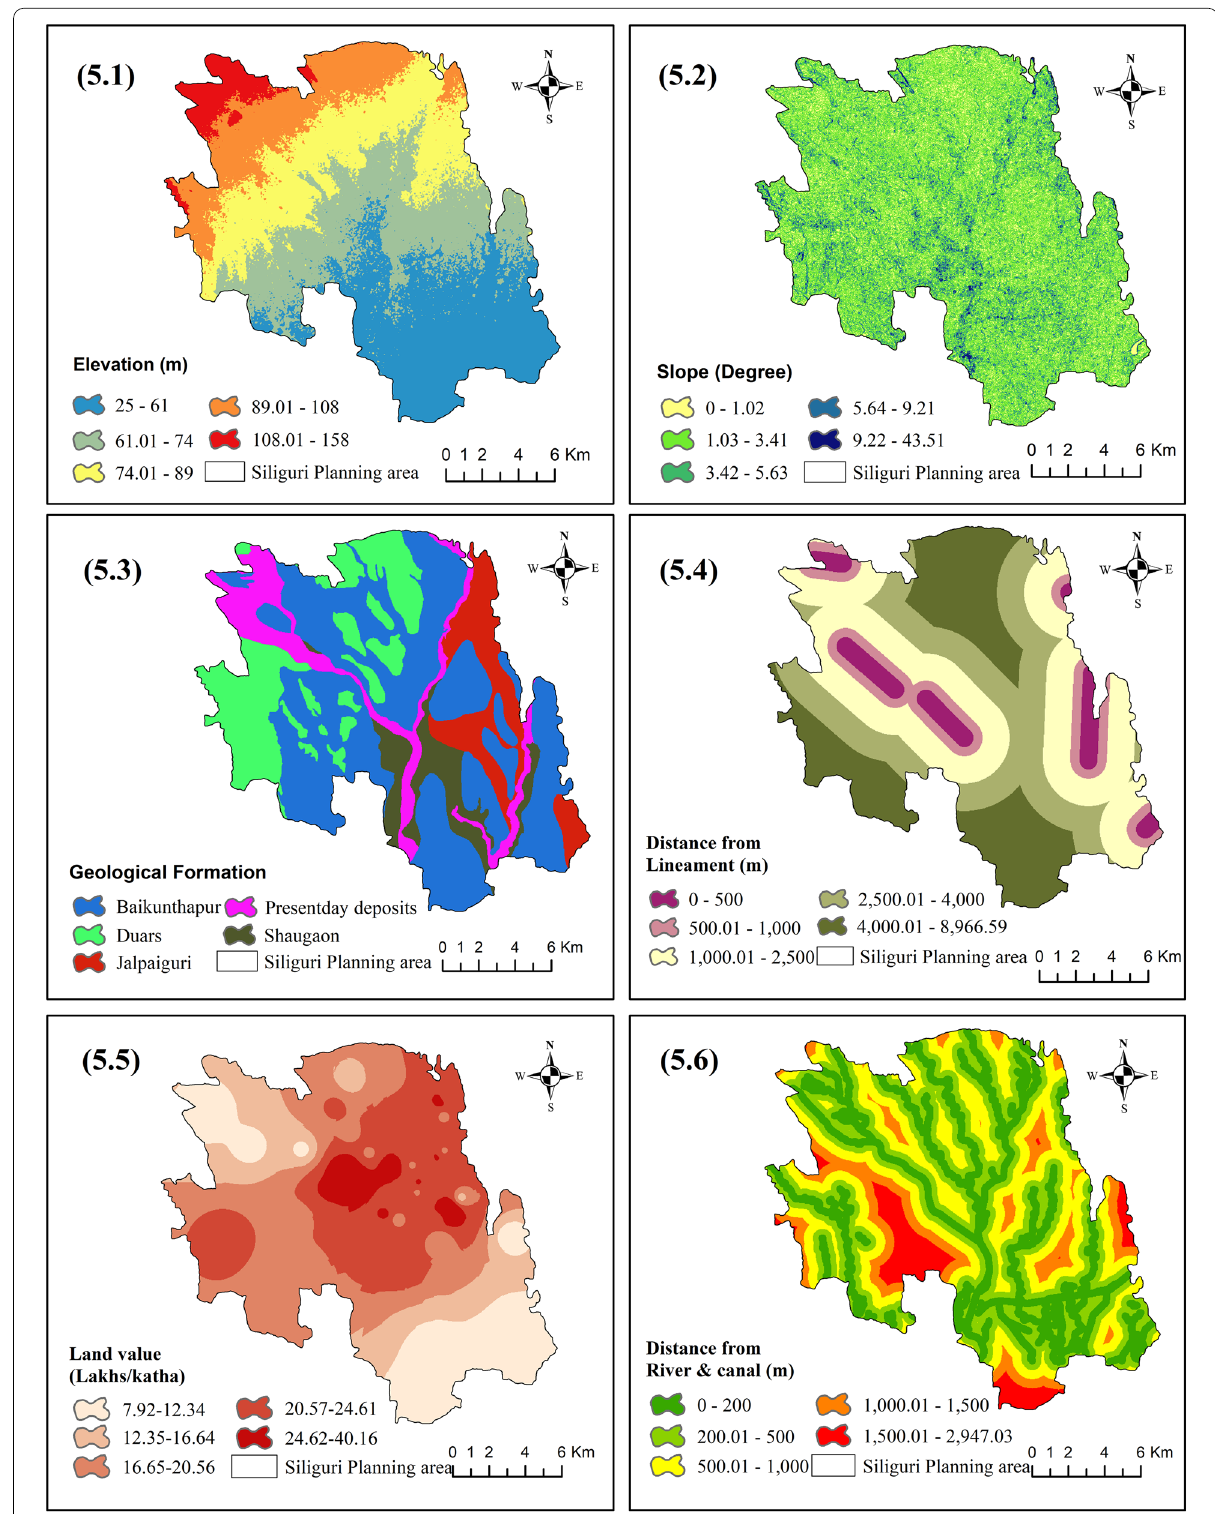
Fig. 4 Raster Layer for Landfill site selection parameter 5.1 Elevation 5.2 Slope 5.3 Geological formation 5.4 Distance from lineament 5.5 Land value 5.6 Distance from River &